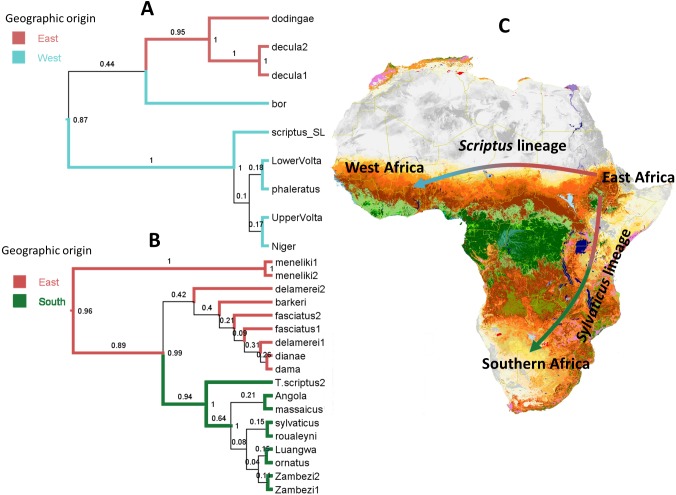
Bayesian ancestral range reconstruction and colonization history of bushbuck based on nDNA markers.(A) Scriptus lineage, (B) Sylvaticus lineage. (C) Colonization routes ofbushbuck species complex identified by BSSVS. Lines between geographic regions represent branches in the MCC tree along which the relevant location transition occurs. Numbers above branches are Bayesian posterior probabilities (PP). The coloured branch lengths represent the ancestral range with highest marginal probability for each lineage as inferred in BEAST (only branches with PP > 0.5). Numbers at each node represent marginal probabilities for alternative ancestral locations.